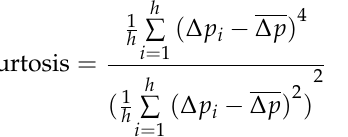
normal distribution, as the reference value to define an index NK, which represents the proportion of the samples of the models whose kurtosis is greater than 3. In a case where the PDF curve of WPFE has obvious multi-peaks, NK can be obtained by using the actual and forecast wind power data to calculate the forecast accuracy of each mode directly. In this paper, by adding constraint on NK in the multi-objective clustering model, as expressed in Equation (8), the clustering results can meet the requirement that the modes with higher forecast accuracy account for the majority of